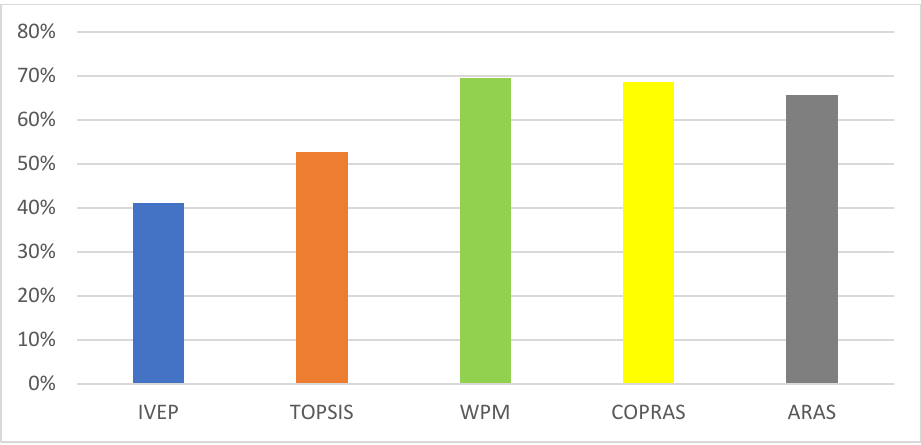
Figure 6. The analytical comparison of the total performance similarity of each MCDM method.